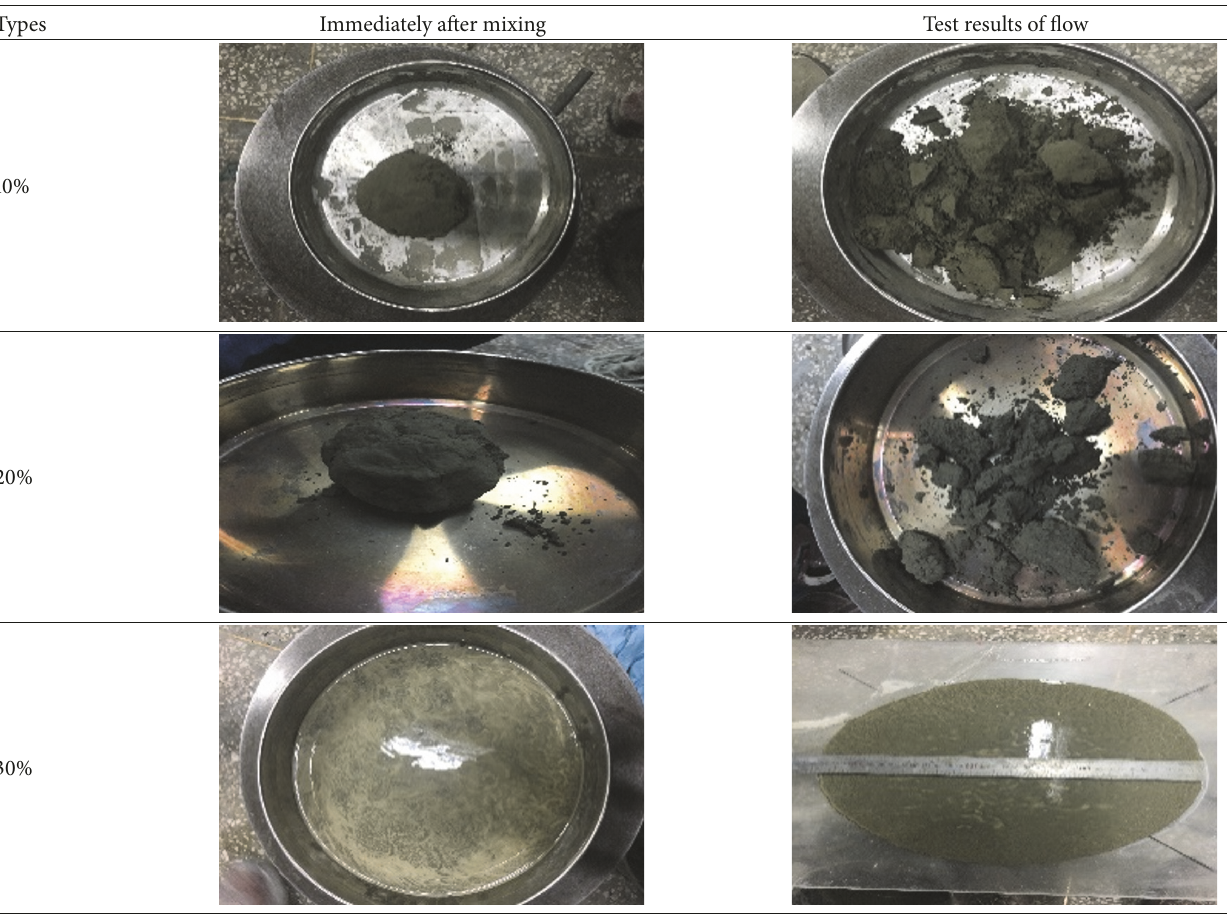
Table 2: Consistencies of Step 1 test group.